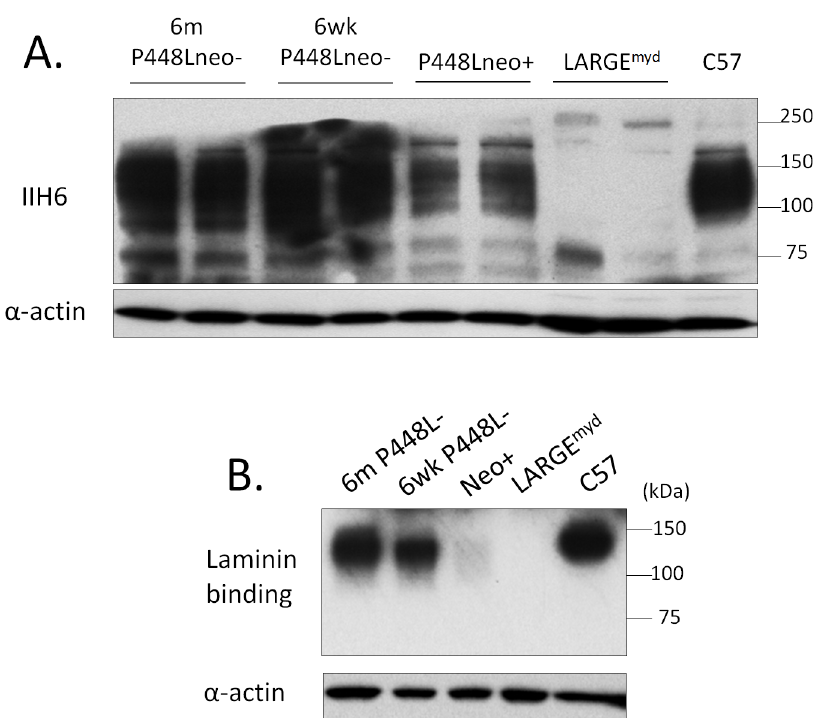
Fig 6. Western blot detection of functionally glycosylated α -DG in sciatic nerve. A. Strong expression is seen in both the 6 week and 6 month old P448Lneo- mouse comparable to C57 control tissue. A decreased expression is seen in the Neo+ and absence in the LARGE myd . B. Laminin overlay demonstrated functional binding of α -DG to laminin in the sciatic nerve. There is minimal binding in the P448Lneo+ with absence in the LARGE myd .